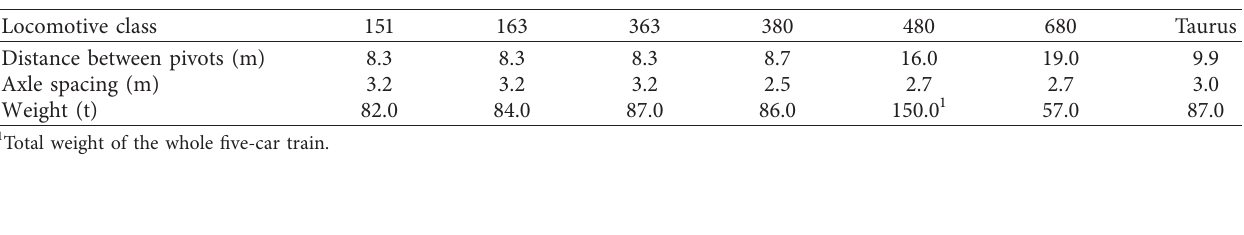
Figure 1: Sensor placement layout around the common crossing of the S&C used for data Table 1: Geometrical parameters and weights of different locomotive classes.